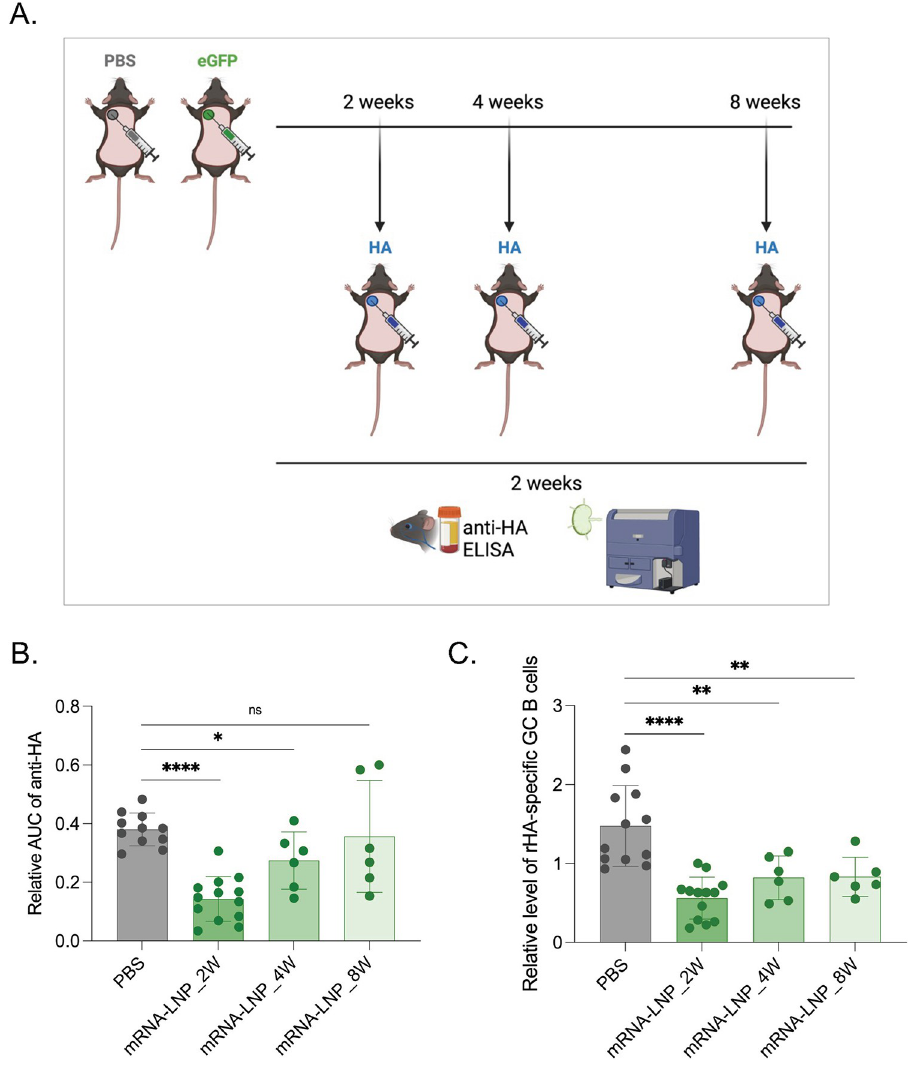
Fig 3. Pre-exposure to mRNA-LNPs has long-lasting effect on adaptive immune responses. A ). Experimental model. Animals at the indicated timepoints post-exposure to PBS or eGFP mRNA-LNP were injected into the same spot with PR8 HA mRNA-LNP and then anti-HA responses assessed as depicted two weeks later. B ). Summary AUC graph on serum anti-HA antibody levels. C ). Relative GC B cell responses from the same mice. Each dot represents a separate mouse. Data from at least two separate experiments pooled and are shown as mean ± SD. One-way ANOVA was used to establish significance. ns = not significant. � p < 0.05, �� p < 0.01, ���� p < 0.0001. Figures were drawn by the authors using